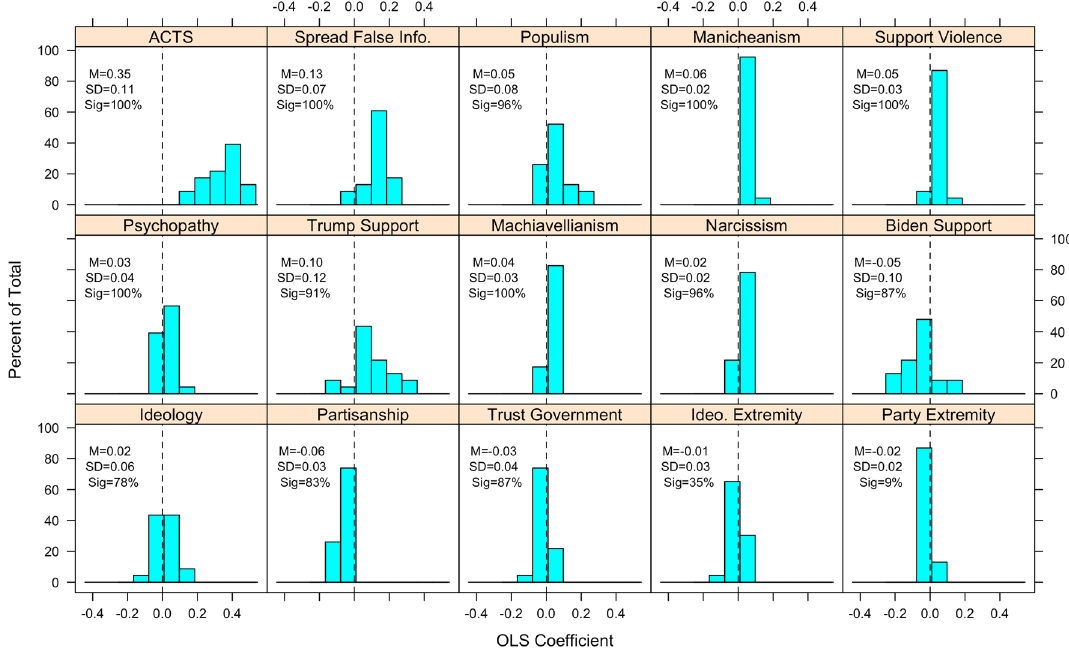
Figure 2. Distribution of standardized OLS coefficients for ordinal conspiracy belief questions, by psychological and political correlates. Mean, standard deviation, and percentage of cases where coefficient was statistically significant ( p < 0.05) appears in text. p -values corrected for multiple comparisons via Benjamini– Hochberg